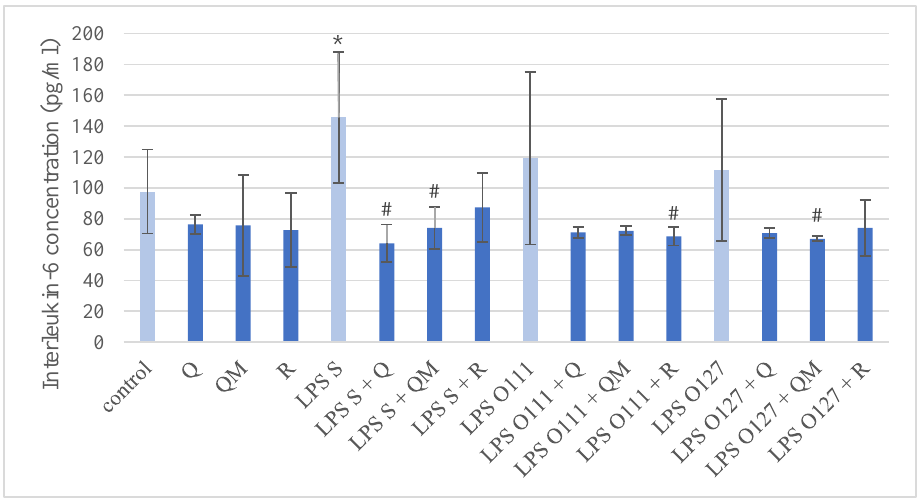
Figure 5. Interleukin-6 (IL-6) concentration in porcine intestinal epithelial cells (IPEC-J2) after treatment with different types of lipopolysaccharides (LPS) from Salmonella Typhimurium (LPS S), E. coli O111:B4 (LPS O111), and E. coli O127:B8 (LPS O127) in 10 µg/mL concentration; quercetin (Q), 3-o-methylquercetin (QM) and rhamnazin (R) in 50 µM concentration; and their combinations. Data are shown as means with standard deviation ( n = 6/group; * significantly higher p < 0.05; # significantly lower p < 0.05) and are statistically compared to those of the control group.